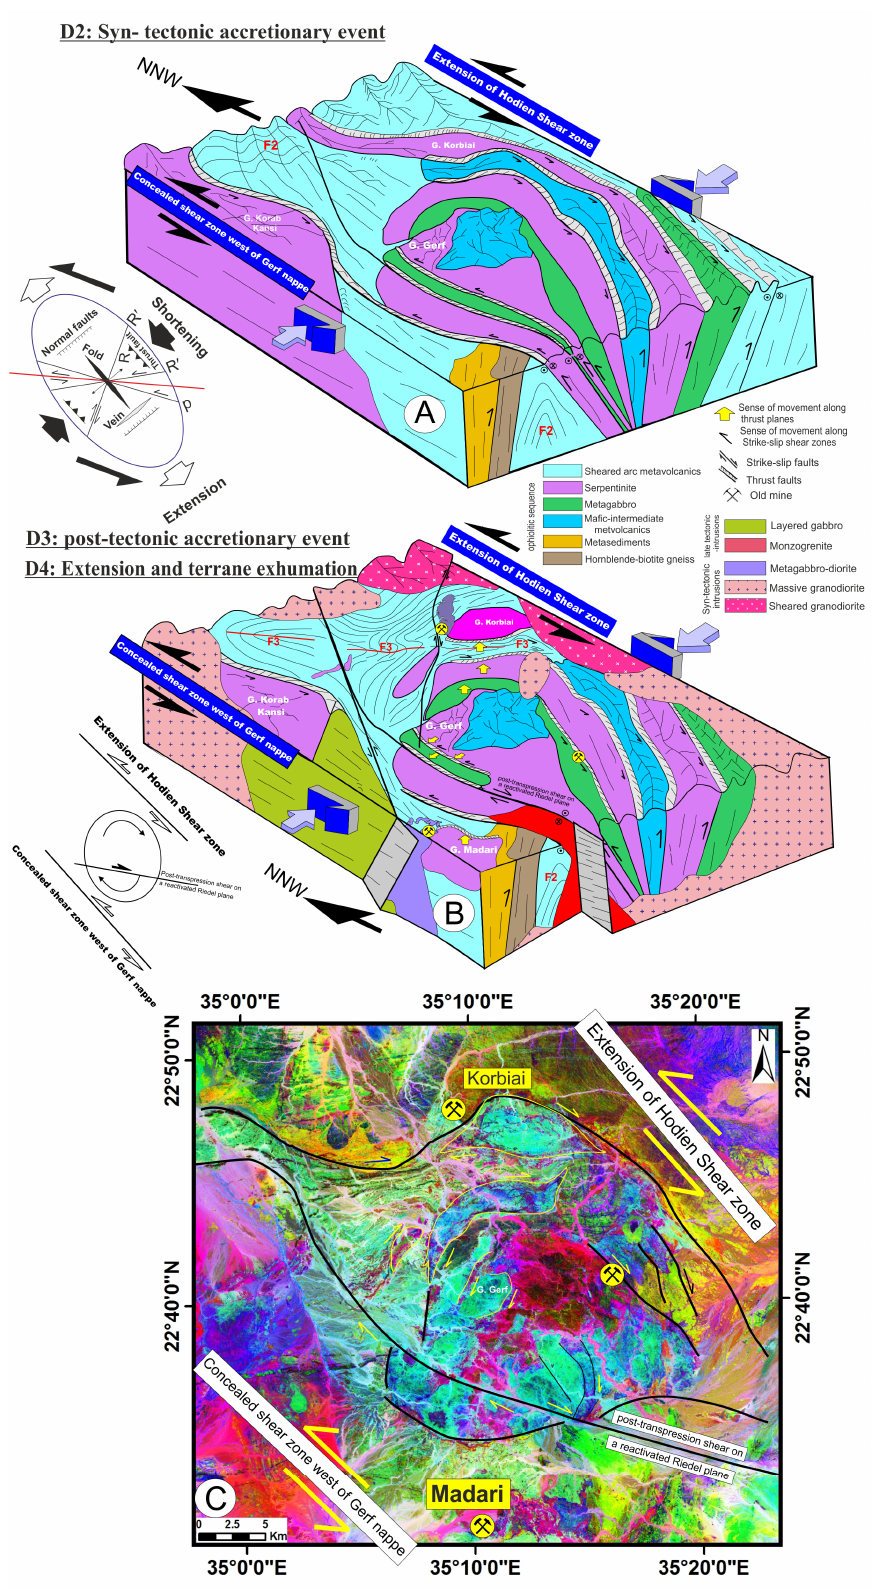
Figure 15. ( A , B ) Sketch block diagrams illustrating the structural evolution of the Gerf area, ( C ) MNF-432 in RGB of S2B showing the major Gerf block formed during the sinistral shearing. The yellow circles in C are the old gold mines in the study